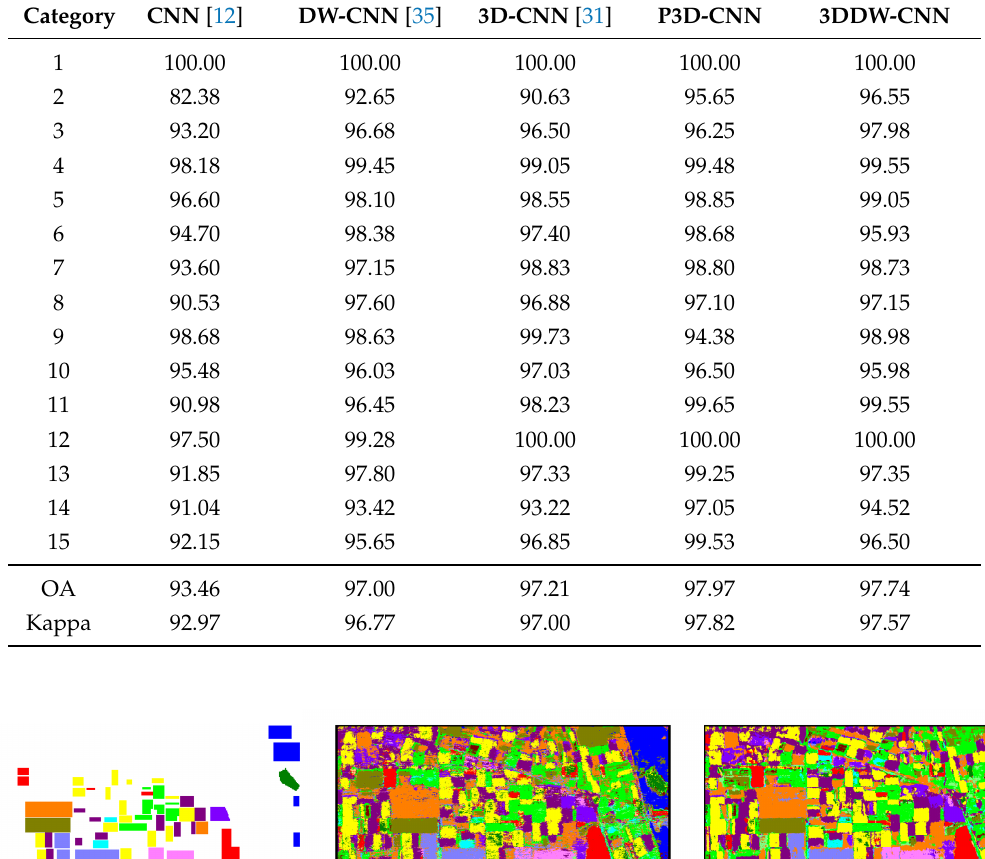
Table 5. Classification results (%) on the AIRSAR Flevoland dataset.